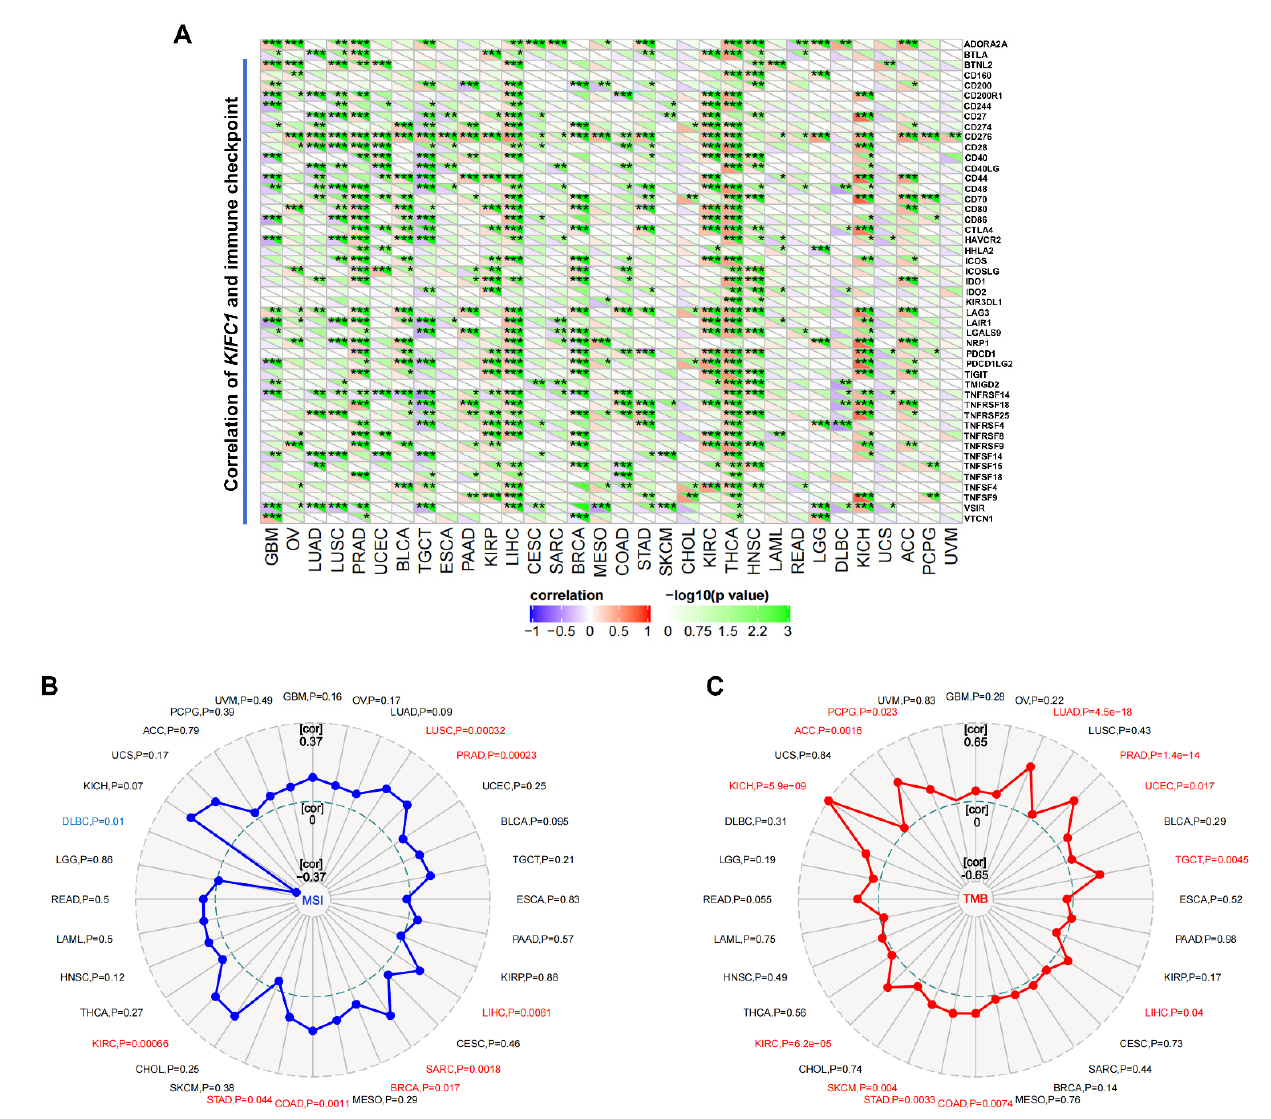
Figure 8. Correlations of KIFC1 expression with immune checkpoints of MSI and TMB in TCGA database . ( A ) Heatmaps represent the color-coded correlations of immune checkpoints and KIFC1 across different tumors. ( B ) Radar chart displays the overlaps between KIFC1 and MSIs. ( C ) Radar chart displays the overlaps between KIFC1 and TMBs. * p < 0.05, ** p < 0.01, *** p < 0.001, in Pearson’s correlation coefficients ( A – C ).